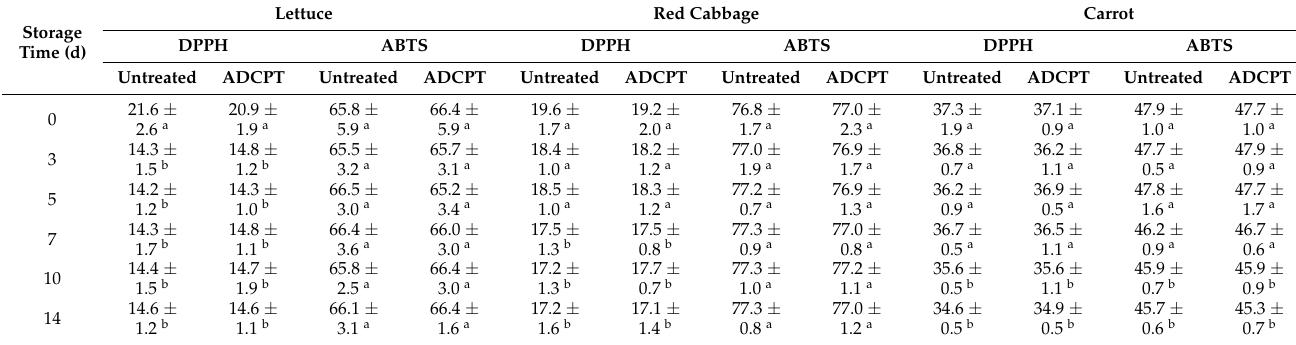
ADCPT, ADCP treated. The values are mean and standard deviation ( n = 8). Means followed by the same lowercase letter in a column are not significantly different at 4 ◦ C ( p >